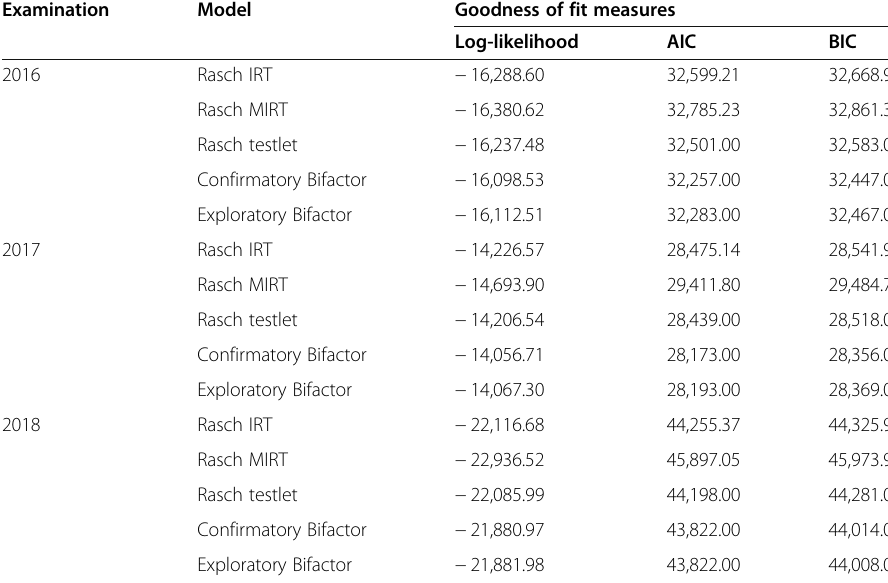
Table 4 Goodness of fit measures of applying the Rasch IRT, MIRT, and testlet models and the bifactor models on the EFL reading comprehension